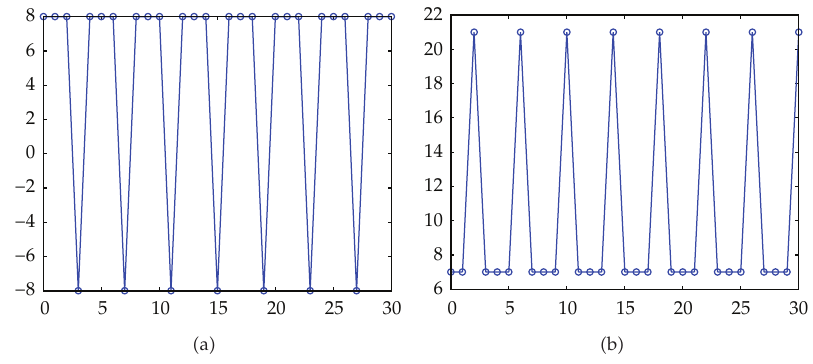
Figure 1: Equation (cid:3) 1.4 (cid:4) . (cid:3) a (cid:4) r (cid:8) − 1 / 3. Initial values y 0 (cid:8) 8 , y 1 (cid:8) 8, y 2 (cid:8) 8 (cid:3) t (cid:8) 8 (cid:4) . (cid:3) b (cid:4) r (cid:8) 1 / 5. Initial values y (cid:8) 7, y (cid:8) 7, y (cid:8) 21 (cid:3) t (cid:8) 7 (cid:4) 0 1 2